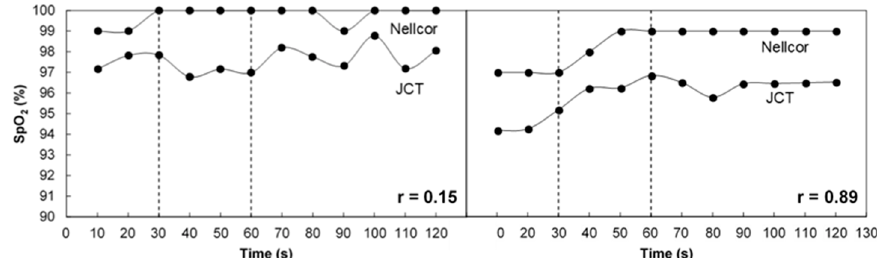
Figure 6. SpO 2 values obtained by the Nellcor and JCT pulse oximeters in two examinations with a relatively low correlation coefficient.